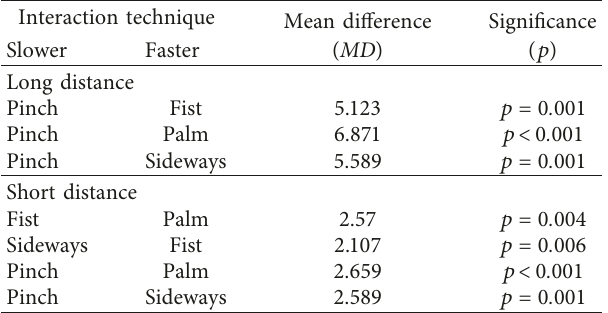
Figure 4: Plot of mean values for (a) MT; (b) ER; (c) TRE. Error bars represent ± 1 SEM. Table 3: Bonferroni corrected post hoc pairwise comparisons of Table 4: Bonferroni corrected post hoc pairwise comparisons of ER MT (sec) for all interaction techniques. for all interaction